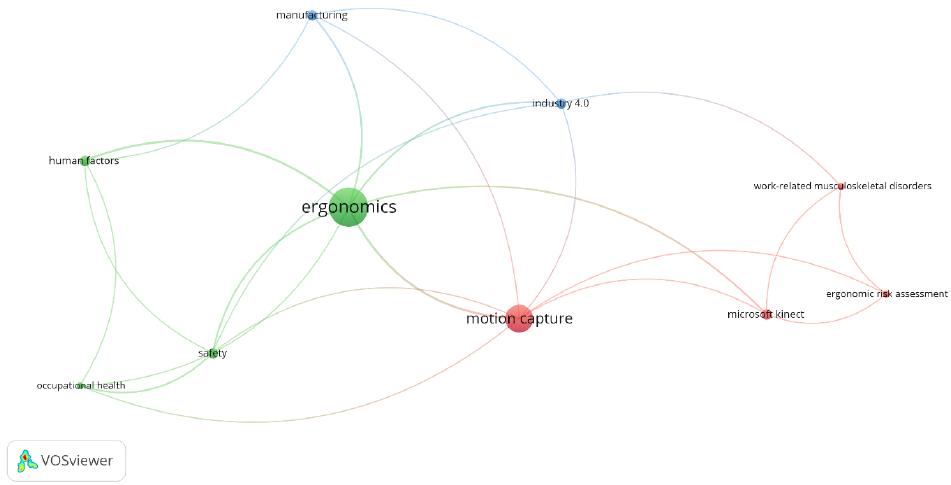
Figure 3. Visualisation of keyword occurrence and relationships by search query using VOS viewer. Source: own processing.